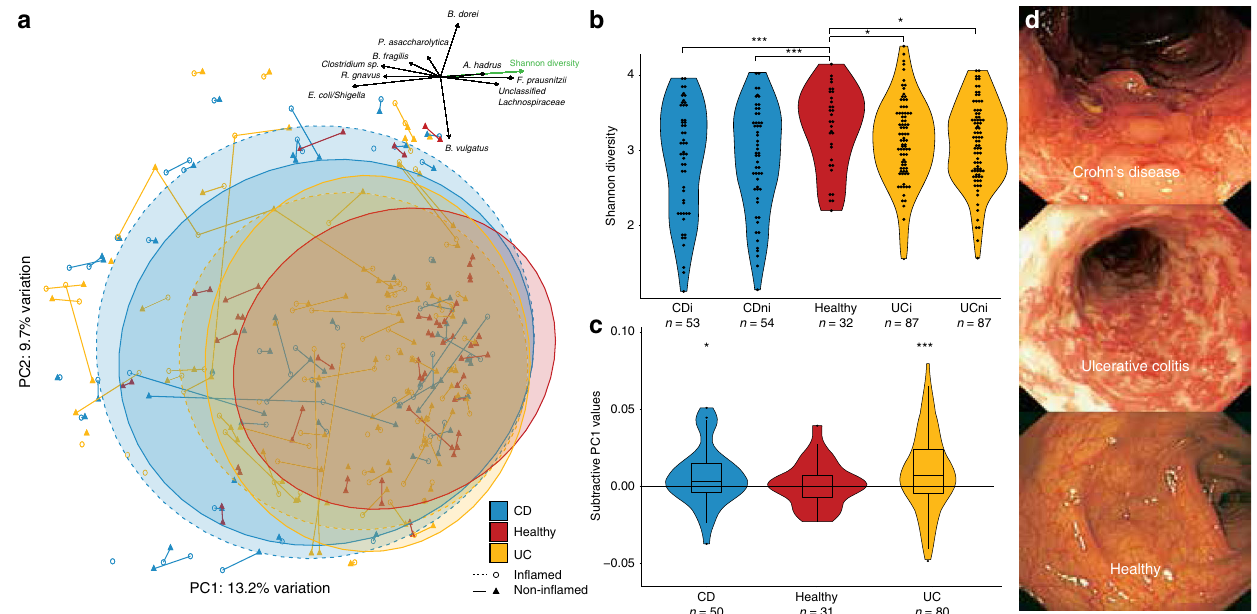
Fig. 1 Overall microbiota composition and diversity of in fl amed and non-in fl amed colonic mucosa from 161 subjects (CD — blue, UC — yellow, and healthy controls — red), based on 257 RSVs that were present in ≥ 5% of the samples. a PCoA of Bray – Curtis distances with paired biopsies from each subject connected by vectors. Ellipses indicate 80% con fi dence regions with solid and dashed lines for non-in fl amed and in fl amed mucosa, respectively. The top arrows represent gradients of Shannon diversity (green) and abundances of a selection of bacterial taxa most correlated with the fi rst two principal coordinates (Supplementary Table 2). b Differences in Shannon diversity were signi fi cantly lower in IBD compared with healthy mucosa (unpaired biopsies included), but not between diseases or for different in fl ammation status (Mann – Whitney test, two-sided; P -values: CDi vs H:0.006; CDni vs H: 0.008; UCi vs H: 0.0102; UCni vs H: 0.050). c For each pair of biopsies PC1, values from the in fl amed sample were subtracted from the non-in fl amed sample for each of the three conditions (reference samples randomly selected for healthy controls). Medians signi fi cantly higher than zero indicate within-patient gradient of in fl ammation away from non-in fl amed/healthy microbiota (one-sample Wilcoxon, two-sided; P -values: CD = 0.08; UC = 0.009; box plot lower and upper sides show 25th and 75th percentiles, respectively. The whiskers are 1.5 of the interquartile range. P -values: *<0.1; **<0.05; ***<0.01). d Representative photographs of colons from CD, UC, and control subjects. Source: ref. 86